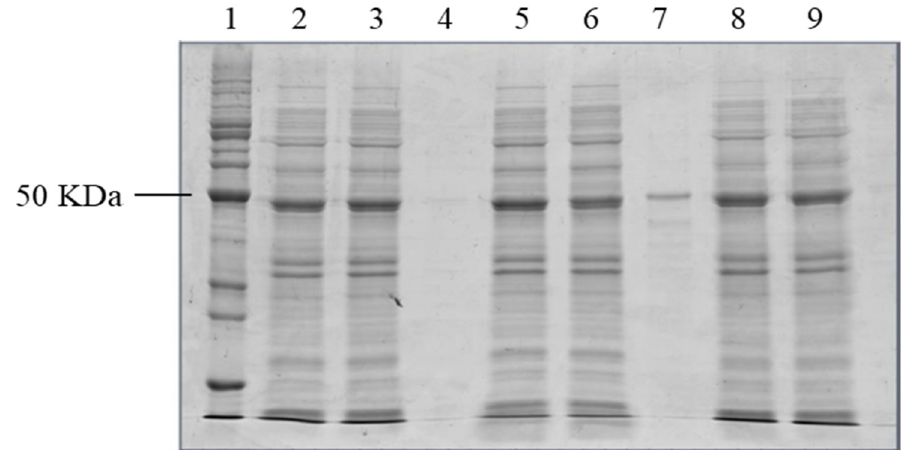
Figure 4. SDS-PAGE of the E-ZIKVre protein solubilization assay expressed in E. coli SHuffle . Line 1—benchmark; line 2—crude extract 4 M urea; line 3—soluble fraction 4 M urea; line 4—insoluble fraction 4M urea; line 5—crude extract 5 M urea; line 6—soluble fraction 5 M urea; line 7—insoluble fraction 5 M urea; line 8—crude extract 6 M urea; line 9—soluble fraction 6 M urea; line 10—insoluble fraction 6 M urea.